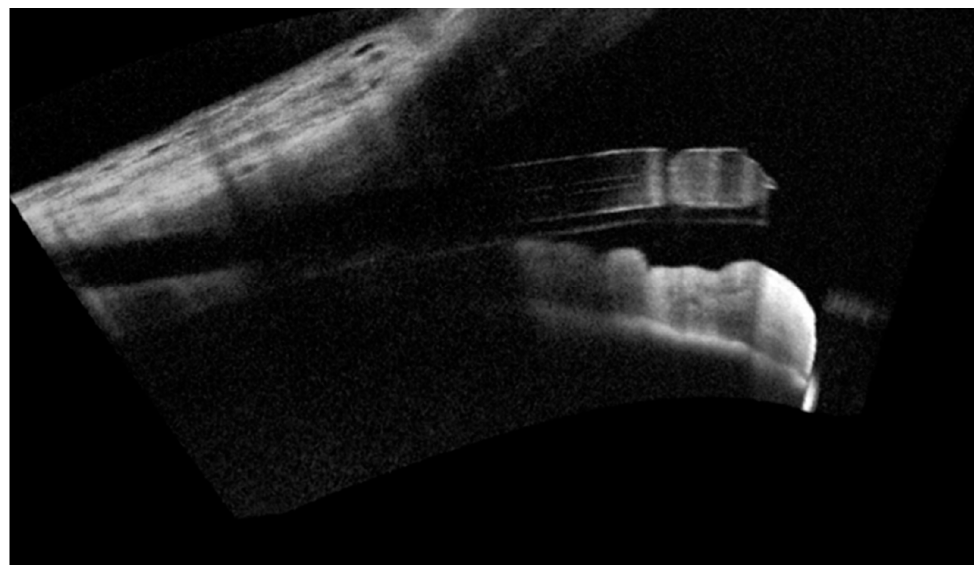
Figure 2. Anterior segment—optical coherence tomography (AS-OCT) showing successfully im- planted PreserFlo MicroShunt, piercing the trabecular meshwork and positioned bevel up in the anterior chamber.